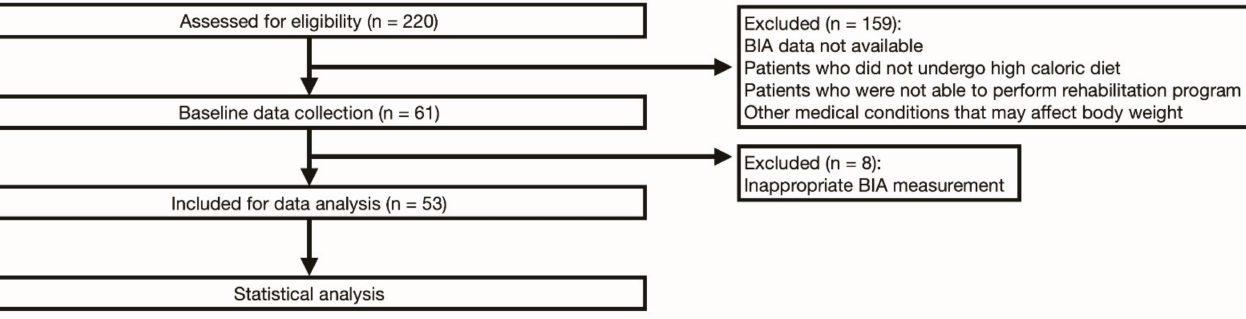
Figure 1. Consort flowchart of the